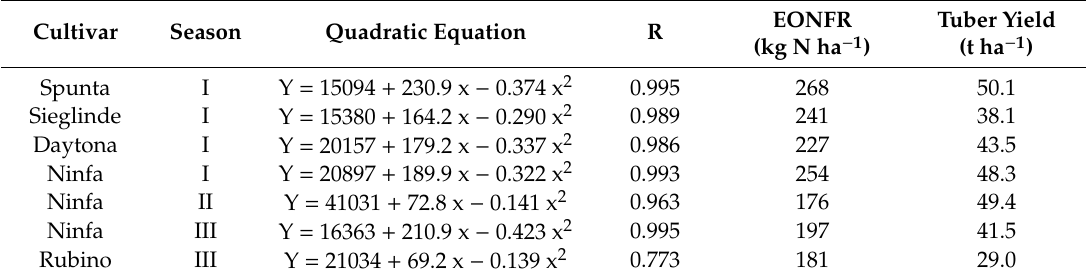
Table 4. Quadratic equations, the economically optimum nitrogen fertilizer rate (EONFR) and corresponding tuber yields in relation to cultivar and season.